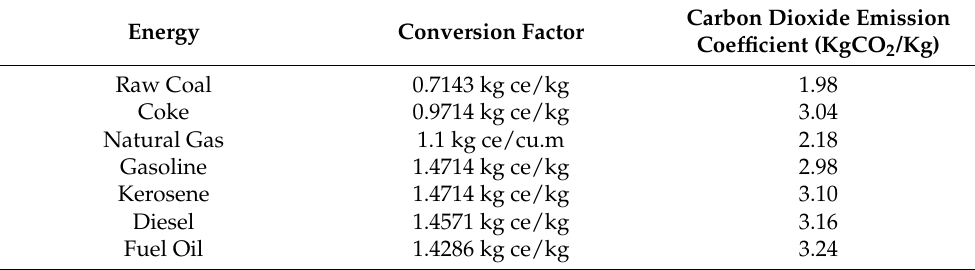
Table 1. Coal conversion coefficient and carbon dioxide emission coefficient of main energy sources. Carbon Dioxide Emission Energy Conversion Factor Coefficient (KgCO 2 /Kg) Raw Coal 0.7143 kg ce/kg 1.98 Coke 0.9714 kg ce/kg 3.04 Natural Gas 1.1 kg ce/cu.m 2.18 Gasoline 1.4714 kg ce/kg 2.98 Kerosene 1.4714 kg ce/kg 3.10 Diesel 1.4571 kg ce/kg 3.16 Fuel Oil 1.4286 kg ce/kg